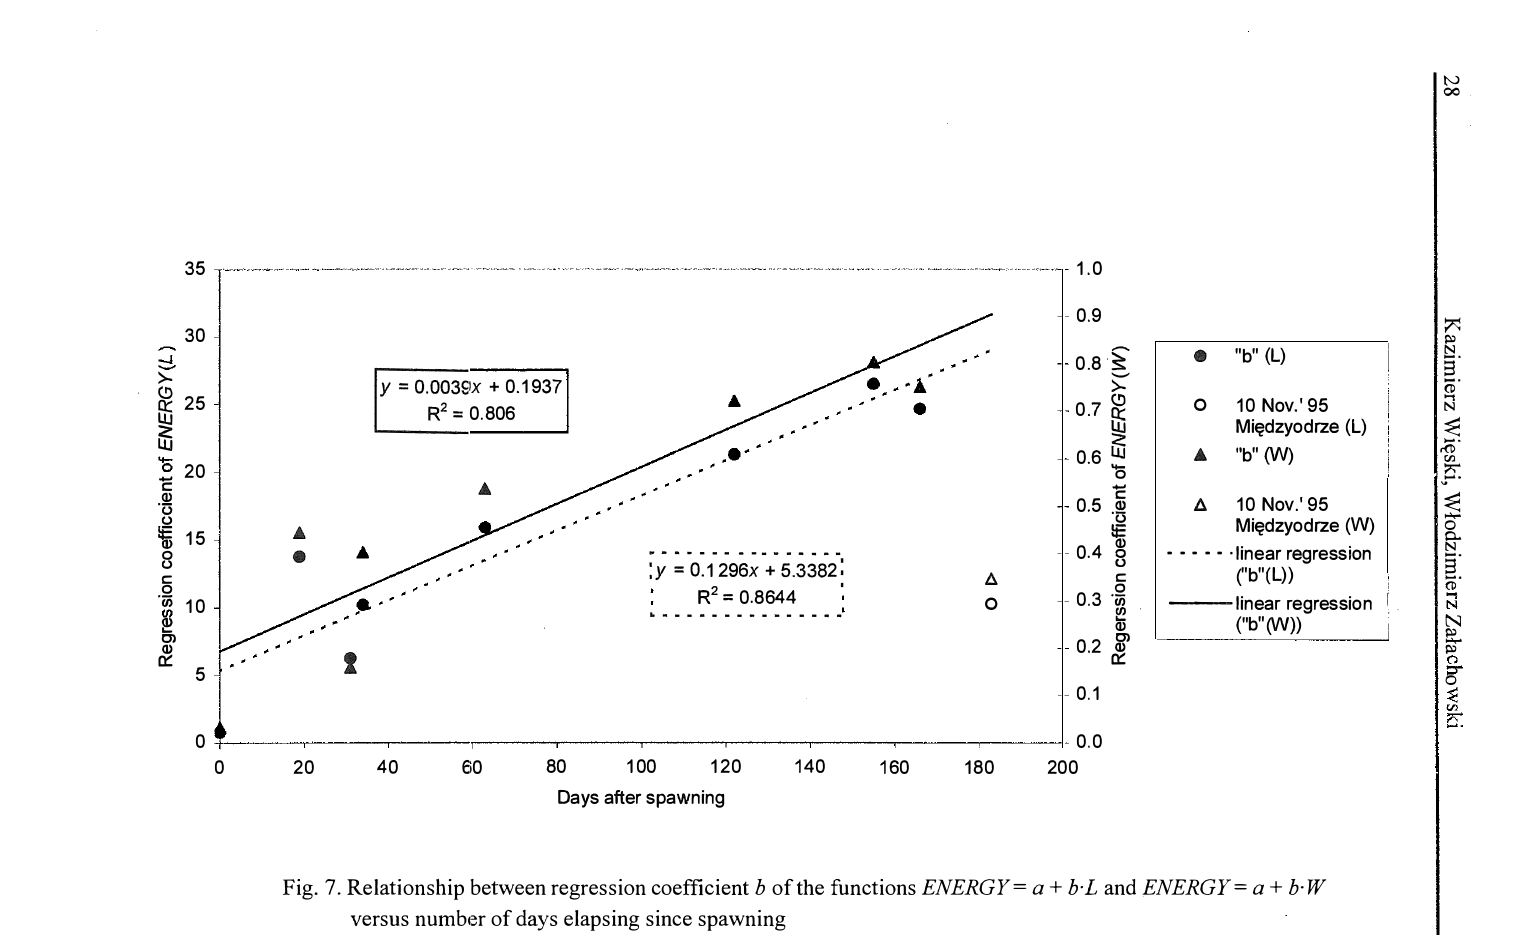
Fig. 7. Relationship between regression coefficient b of the functions ENERGY = a+ b·L and ENERGY= a+ b·W versus number of days elapsing since